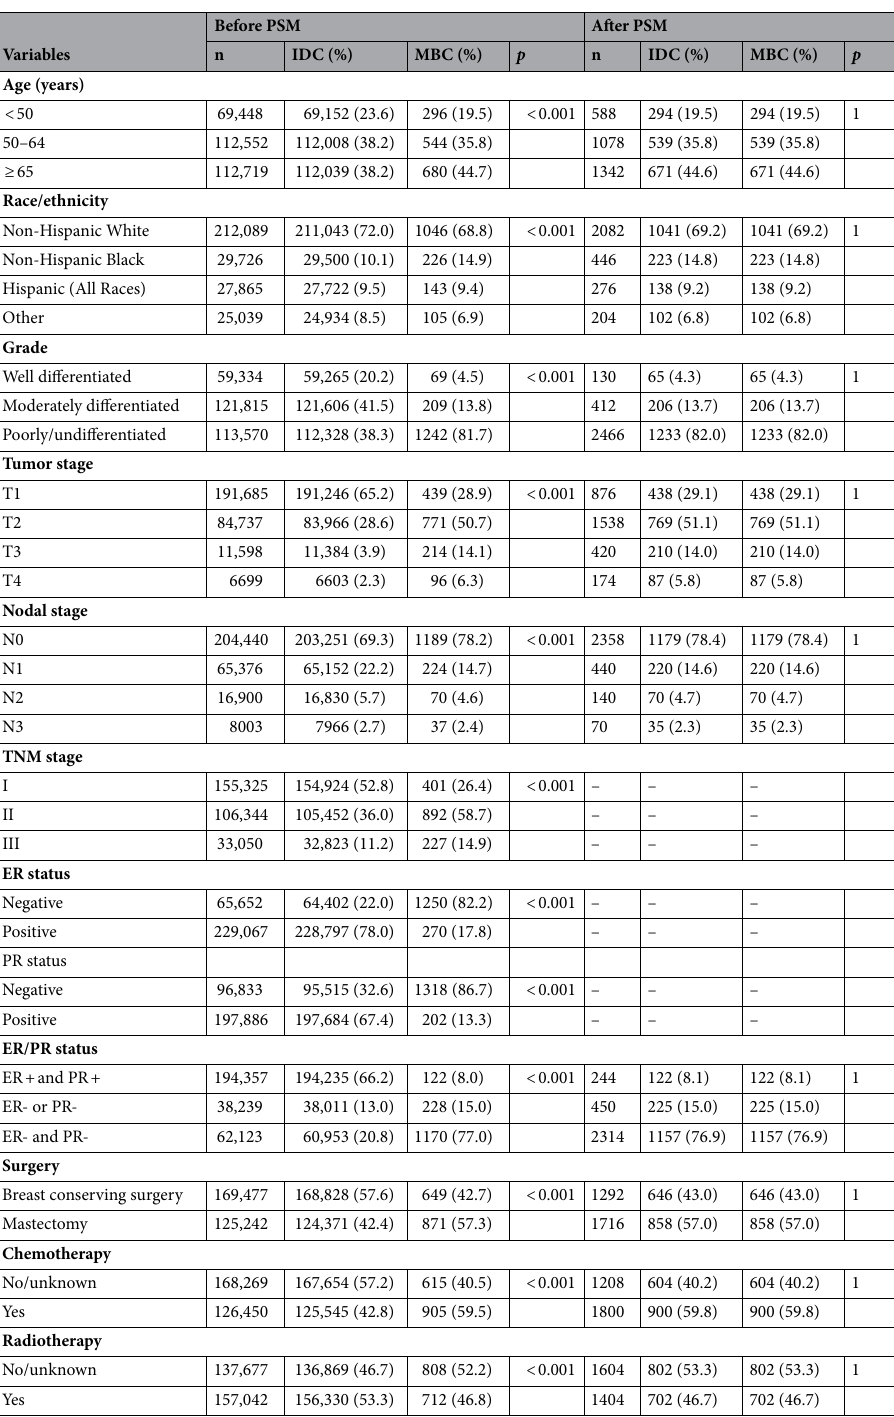
Table 1. The patients demographic, clinicopathological, and treatment between invasive ductal carcinoma and metaplastic breast carcinoma before and after propensity score